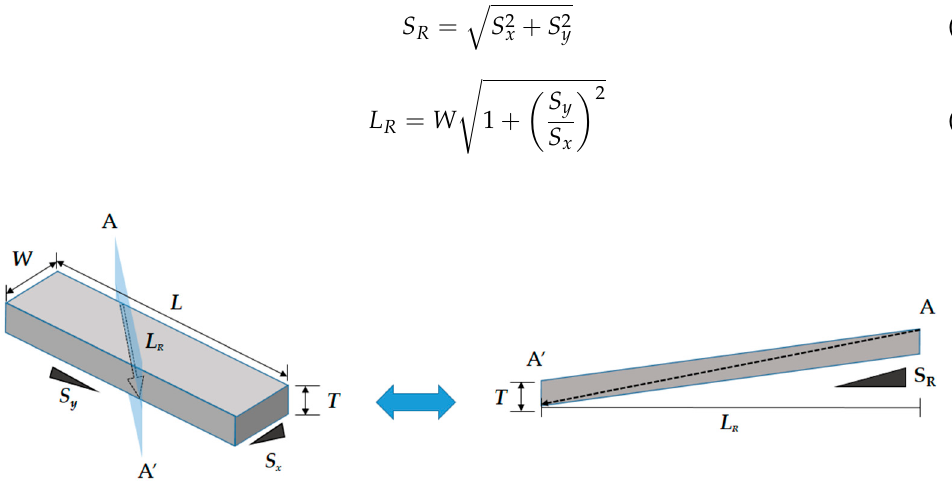
Figure 2. Equivalent water flow path: length ( L R ) and slope ( S R ).